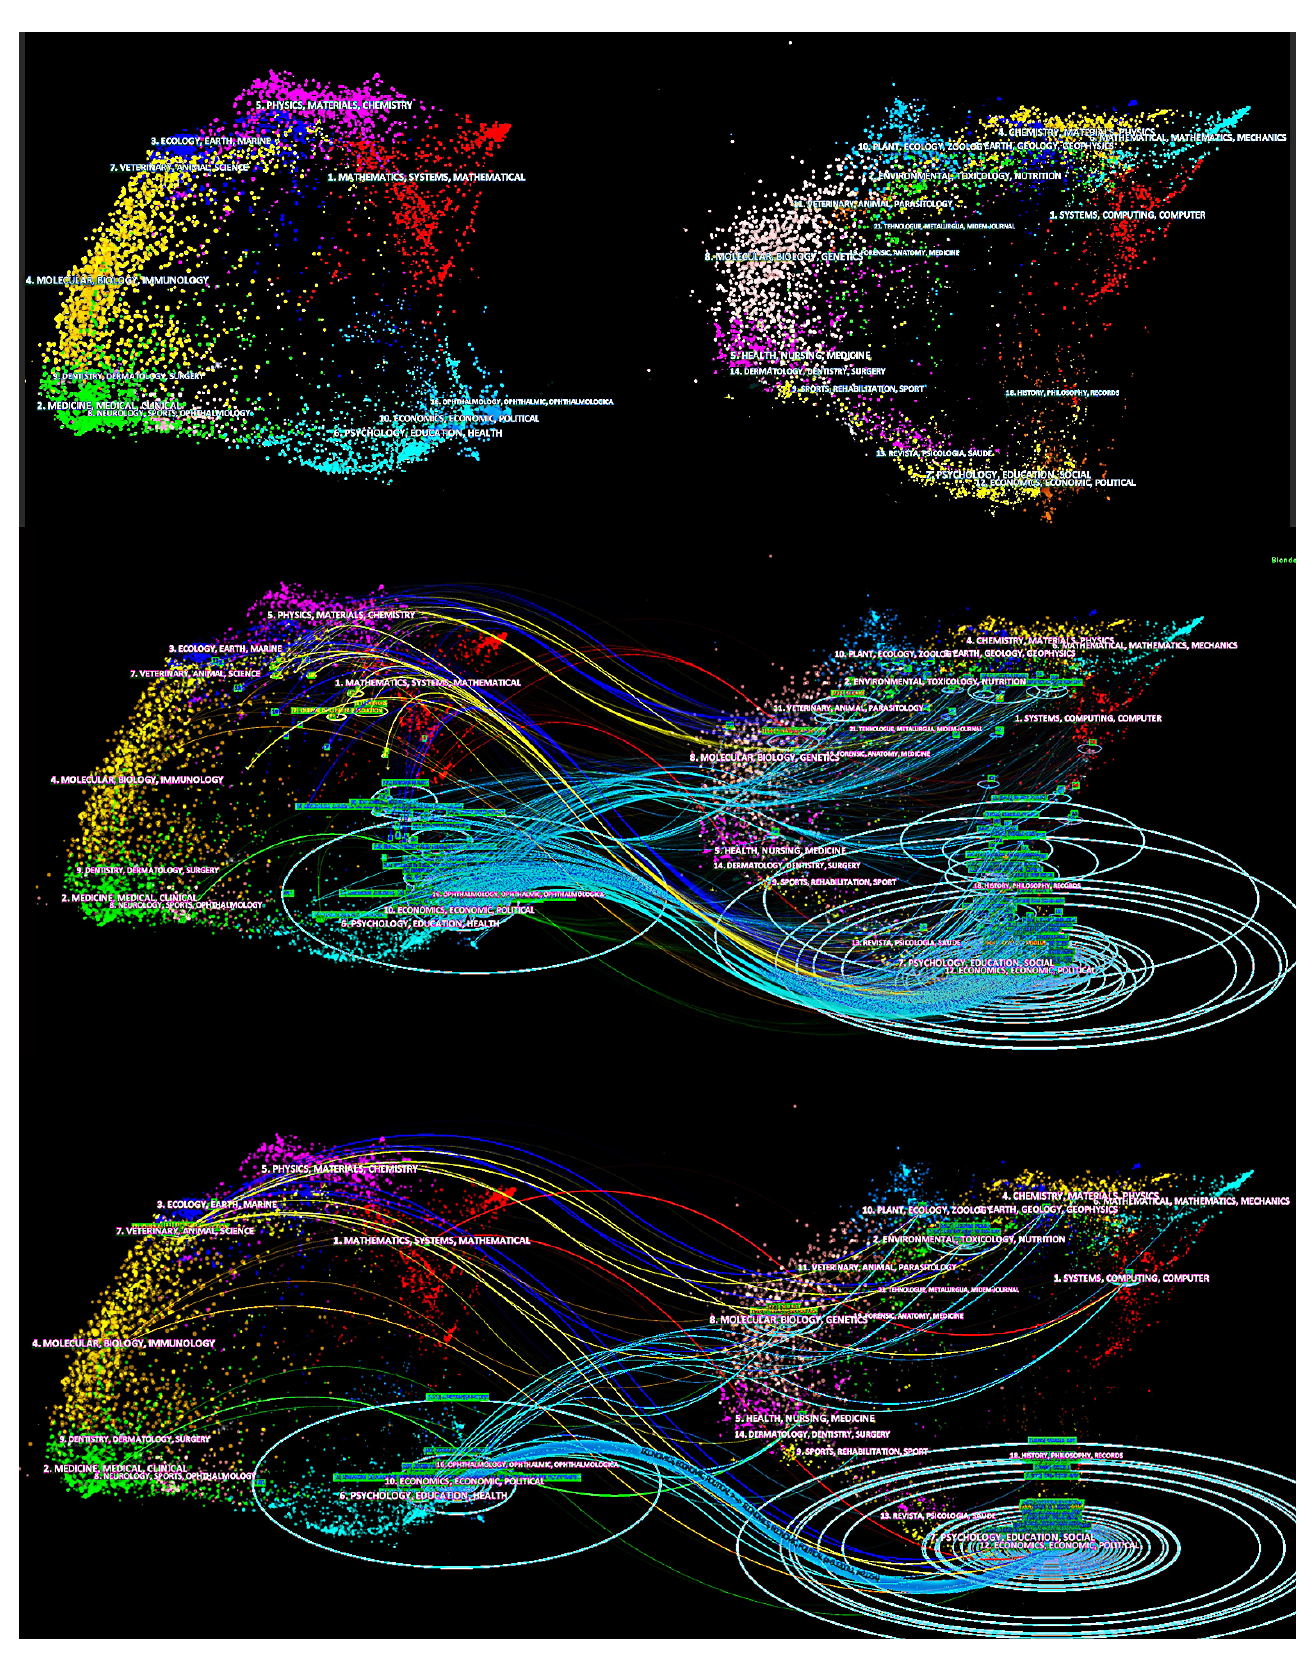
Figure 13. The journal–based dual–map of the Resource Curses, Dutch Diseases, and Conflict Resources–related papers on the global scientific mapping.